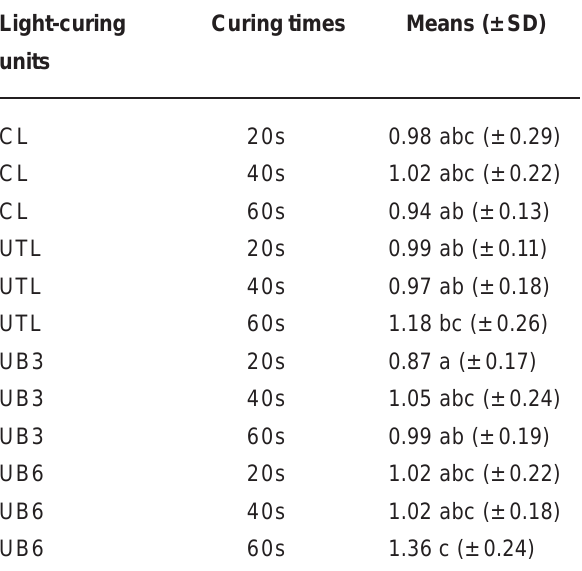
TABLE 1- Composite resin tensile bond strength means (MPa) and standard Light-curing